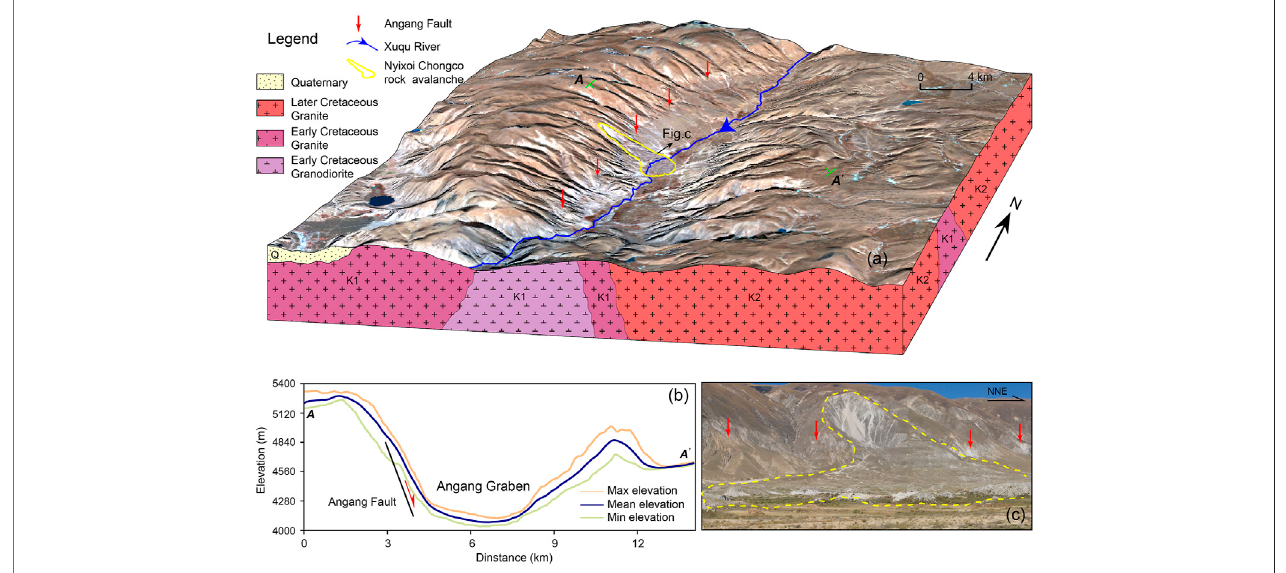
FIGURE2|(A) ThetopographyandrocktypesoftheAnganggraben. (B) Swathpro fi leshowsthesigni fi canttopographiccharacteristicsonthewesternsideofthe Angang graben due to continued activity on the Angang fault. (C) The source area of the NCRA is located above the fault scarps of the Angang fault.